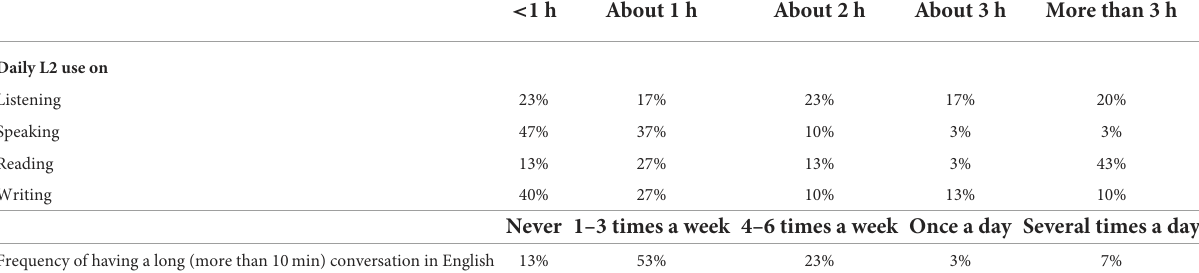
TABLE 4 Participants’ L2 use ( N =